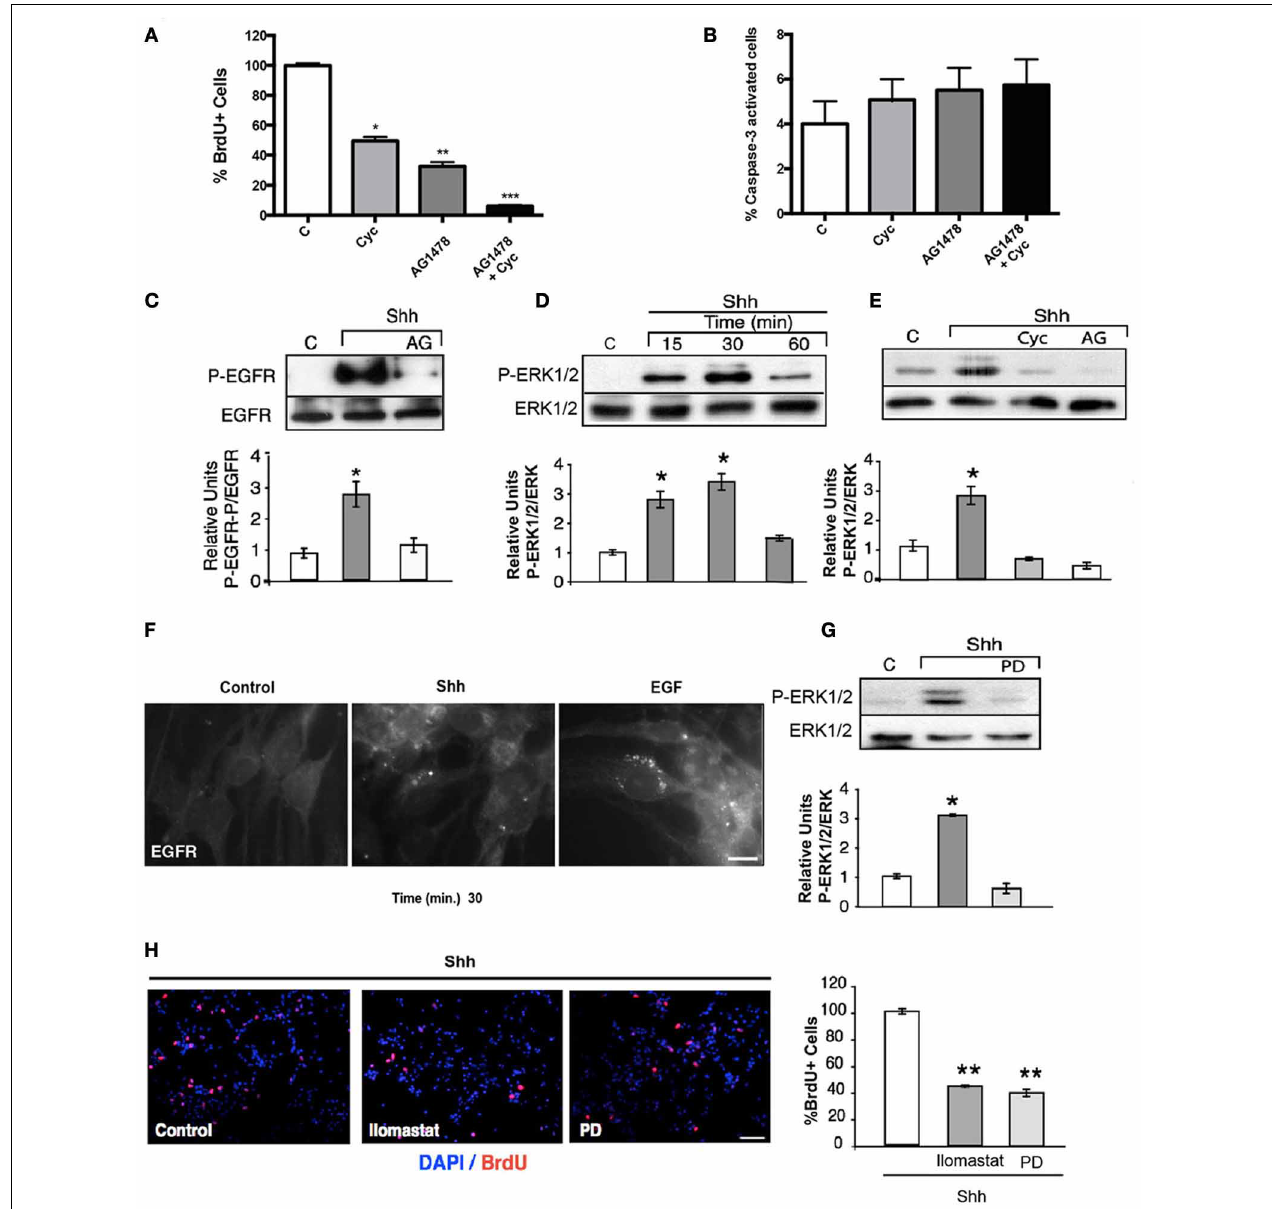
FIGURE 1 | Shh stimulation transactivates the EGFR leading to mitogenic signaling via the ERK1/2 pathway. (A) EGF-dependent NSC proliferation requires the Shh signaling pathway. Quantification of the percentage of BrdU + cells. The mitogenic activity decreased significantly with either cyc (50%; ∗ p < 0 . 03) or AG1478 (70%; ∗∗ p < 0 . 01) and was almost completely abrogated with both inhibitors (90%; ∗∗∗ p < 0 . 001). (B) Cells were treated with EGF (10ng/ml), in the presence of either Cyc (10 μ M), AG1478 (100nM) or both drugs. Cells were fixed and cell death was evaluated by positive caspase-3 labeling. The histogram shows that treatment with inhibitors does not significantly change the percentage of caspase-3-activated cells. Data represent the results of three independent experiments. (C) Transactivation of the EGFR by Shh. Shh (3 μ g/ml) induced an increment in the phospho-tyrosine activity of the EGFR, which was abolished by AG1478 (100nM), added 30min before. Tyrosine phosphorylation of EGFR was detected by immunoblot after immunoprecipitation. (D,E) Shh induces EGFR-dependent ERK1/2